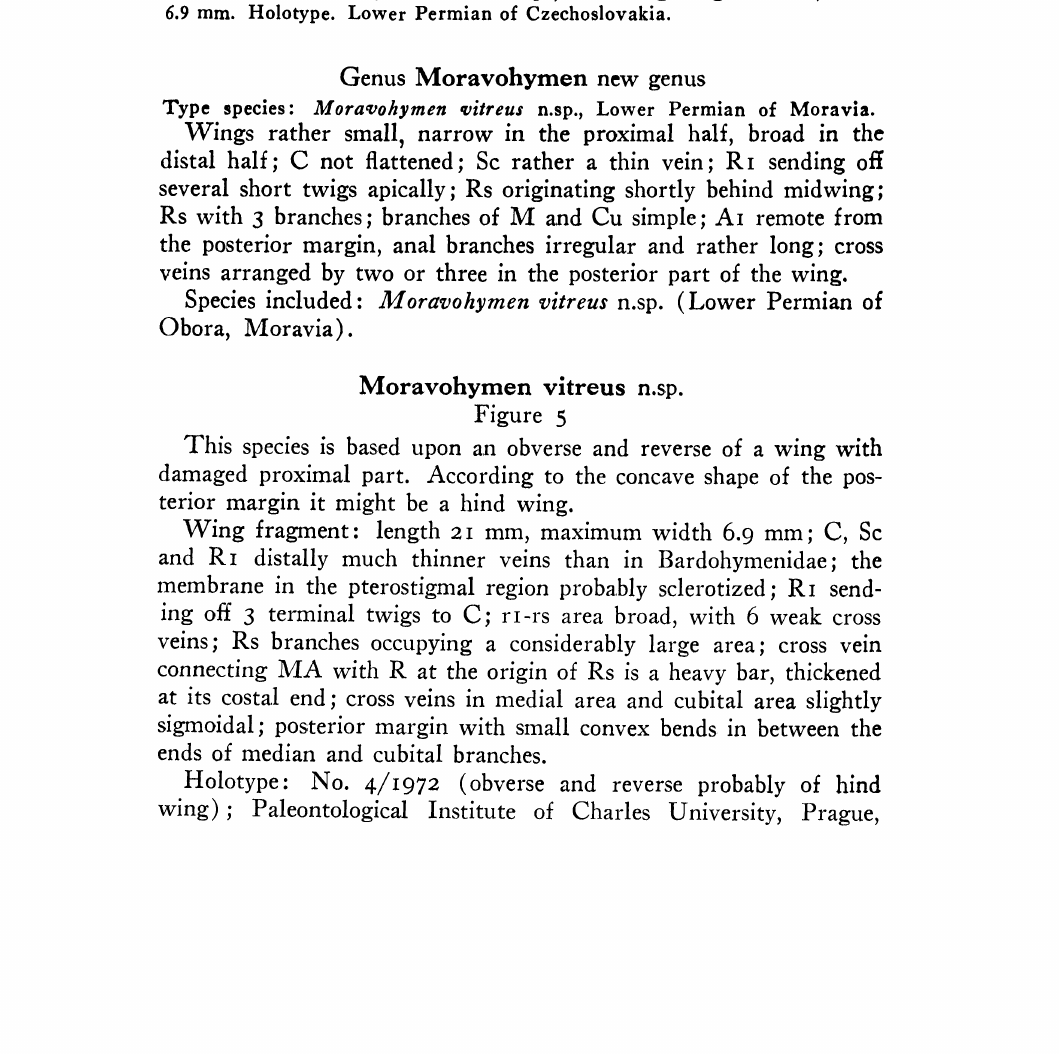
Figure 5. Moraohymen itreus n.sp.; hind wing" length 21 mm, width 6.9 mm. Holotype. Lower Permian of